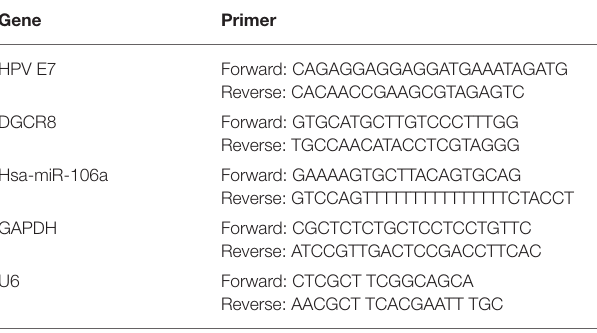
TABLE 1 | The primer sequences for RT-qPCR. Gene